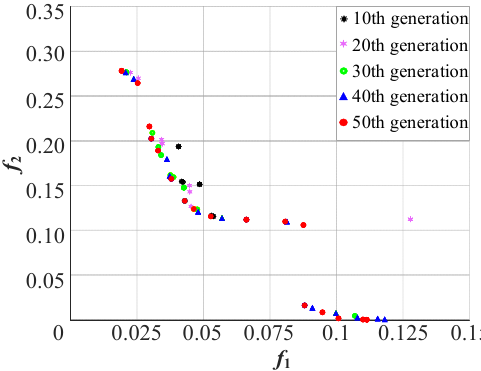
Figure 11. 2D view of the Pareto solution trajectory of the hybrid algorithm.